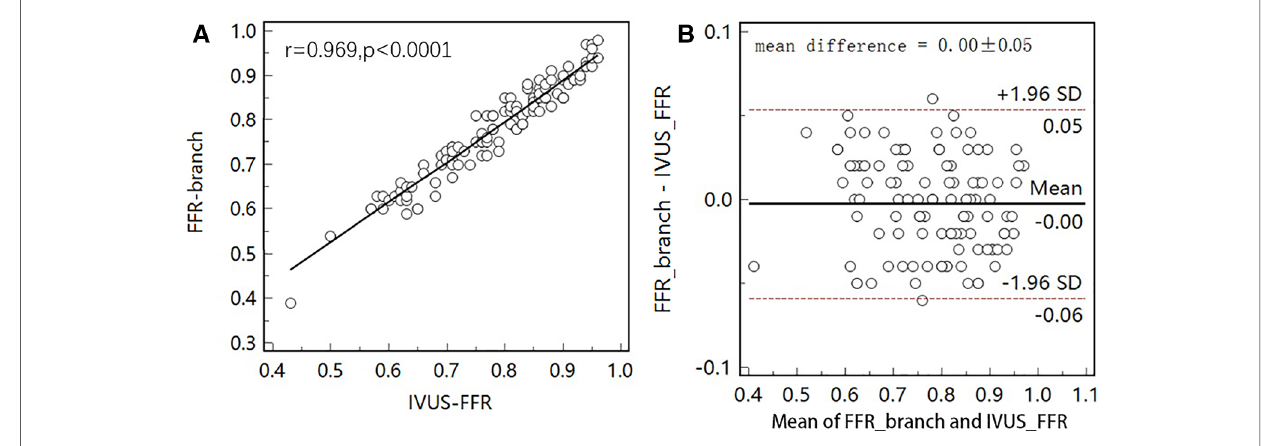
FIGURE 7 Correlation and agreement between IVUS-FFR and FFR-branch. ( A ) Strong correlation ( r ¼ 0 : 969) between IVUS-FFR and FFR-branch was observed. ( B ) Bland-Altman plot shows good agreement between IVUS-FFR and FFR-branch.